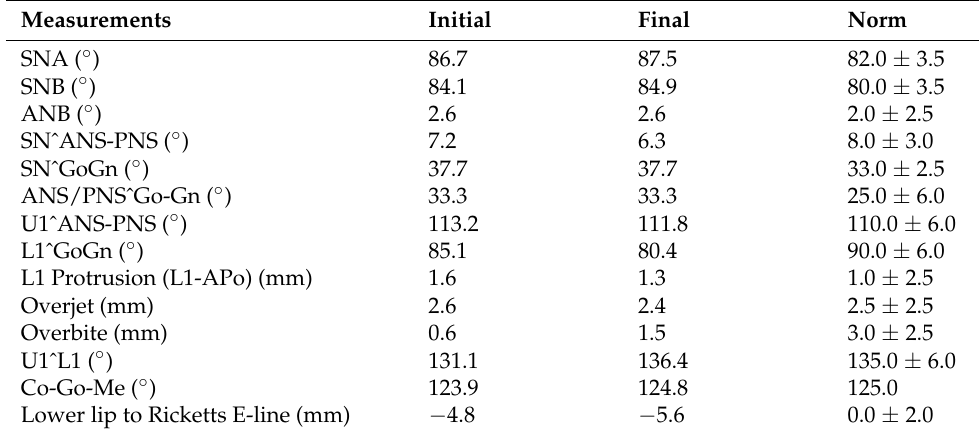
Table 1. Cephalometric measurements before and after